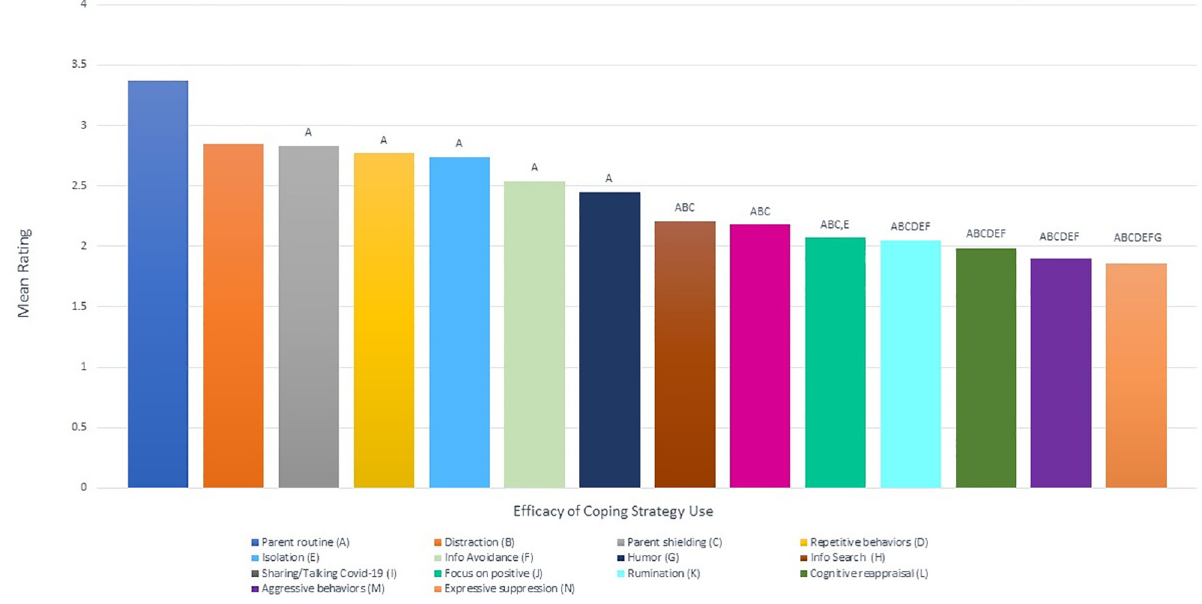
Fig 2. Pairwise comparisons between efficacies of coping strategies. The x-axis represents each of the 14 behavior survey questions. The letters represent all significant pairwise comparisons for the corresponding survey question.